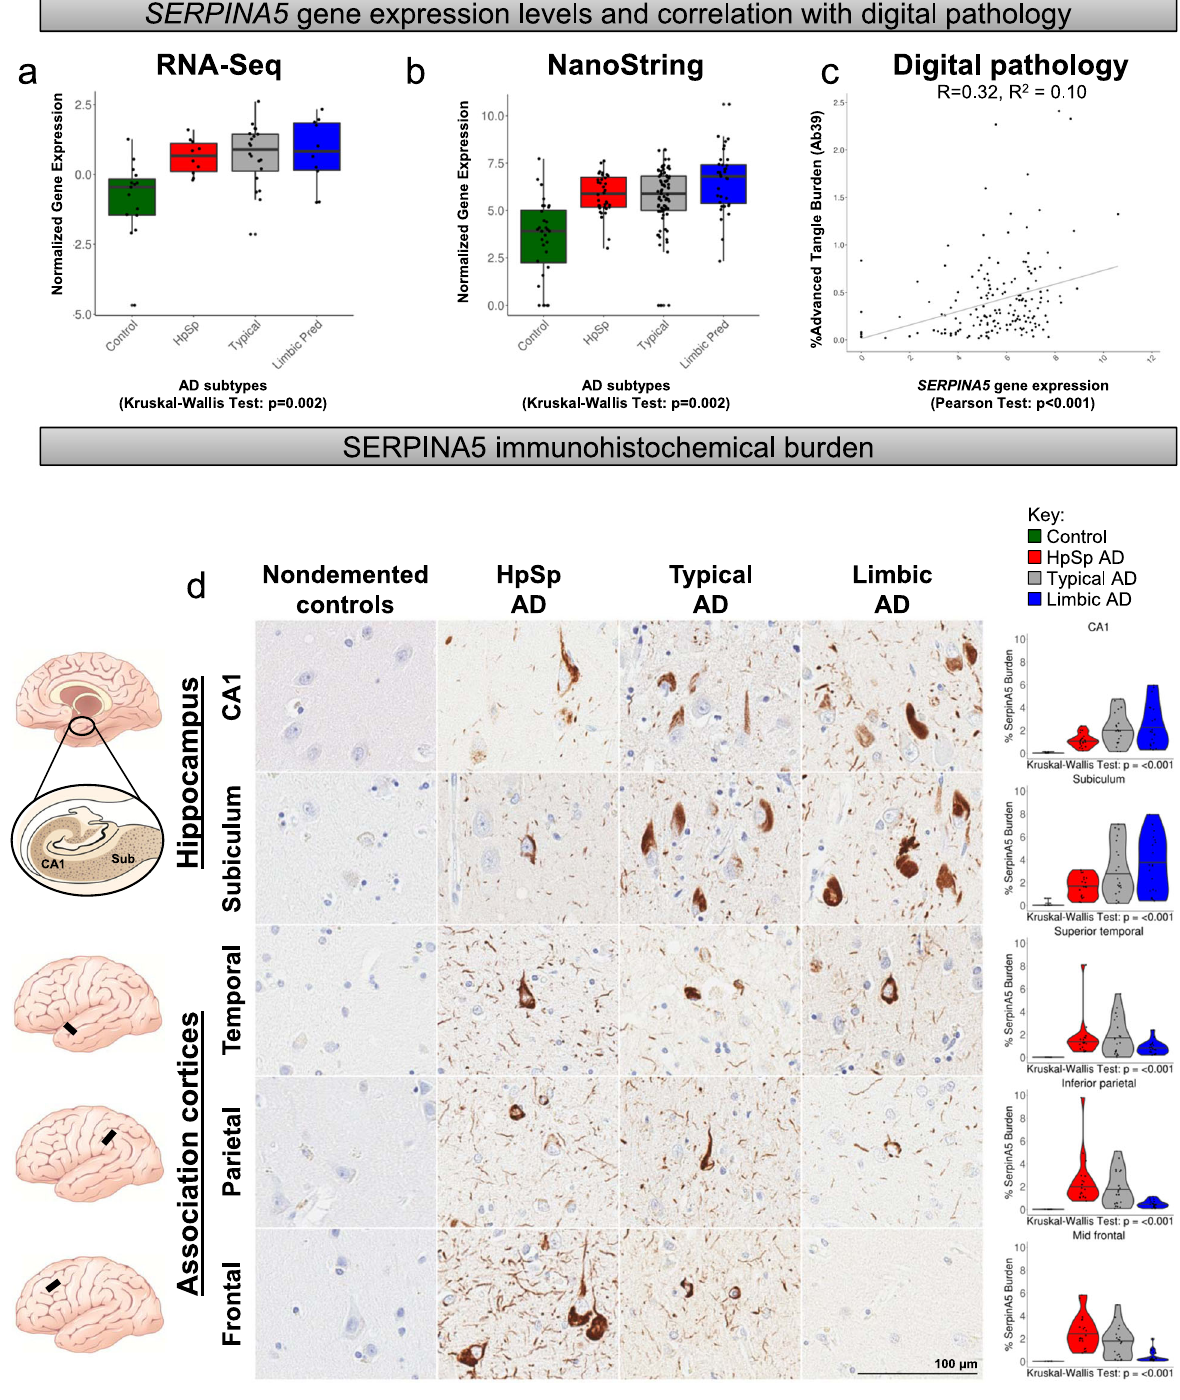
Fig. 5 SERPINA5 gene expression changes differ among AD subtypes and track with advanced neuro fi brillary tangle pathology. a , b SERPINA5 expression increases in a monotonic fashion among AD subtypes in the RNA-Seq cohort ( a ), which was replicated in the larger NanoString cohort ( b ). c SERPINA5 gene expression from NanoString cohort associates with % burden of advanced tangle maturity marker Ab39 using two-sided Pearson correlation analysis. d Immunohistochemical investigation of SERPINA5 in controls ( n = 10) and among AD subtypes ( n = 20 per subtype) reveals a monotonic increase in hippocampal subsectors and a monotonic decrease in the association cortices. Pair-wise comparisons for graphs can be found in Supplementary Fig. 2. Scale bar represents 100 µ m. AD, Alzheimer ’ s disease; A β , amyloid- β ; HpSp, hippocampal sparing; Limbic, limbic predominant; RNA- Seq, RNA sequencing. Note: control cases = green, hippocampal sparing AD = red, typical AD = gray, limbic predominant AD = blue. Box plots in a and b are derived from n = 55 and n = 182 independent samples, respectively. Box plots are displayed at the 25th and 75th percentiles with the median line. Whiskers are drawn to the largest and smallest values that are within 1.5 times the interquartile range from the upper or lower quartile. For observations larger or smaller than this distance, they are shown as observations outside the